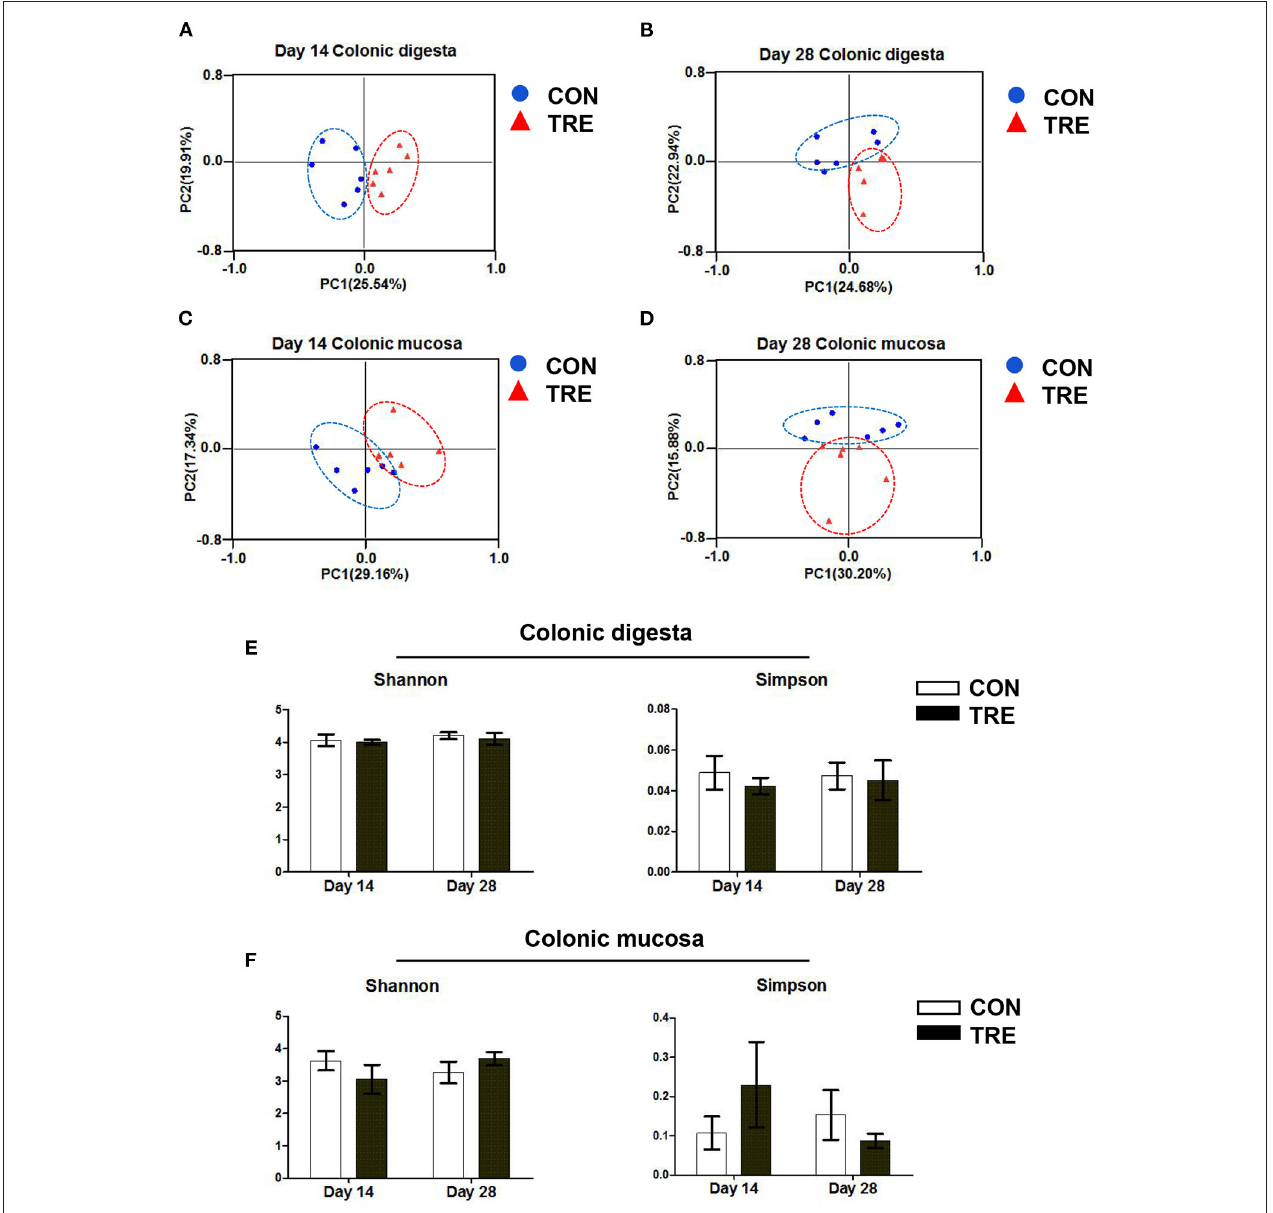
FIGURE 4 | Effect of protein restriction and succedent realimentation on bacterial diversity of different colonic niches in weaned piglets ( n = 6). (A) Alterations of β -diversity in colonic digesta on day 14. (B) Alterations of β -diversity in colonic digesta on day 28. (C) Alterations of β -diversity in colonic mucosa on day 14. (D) Alterations of β -diversity in colonic mucosa on day 28. (E) Alterations of α -diversity in jejunal digesta on day 14 and 28. (F) Alterations of α -diversity in jejunal mucosa on day 14 and 28. P < 0.05 were considered significant and markers (*) between groups on the same day. CON, control group; TRE, treatment